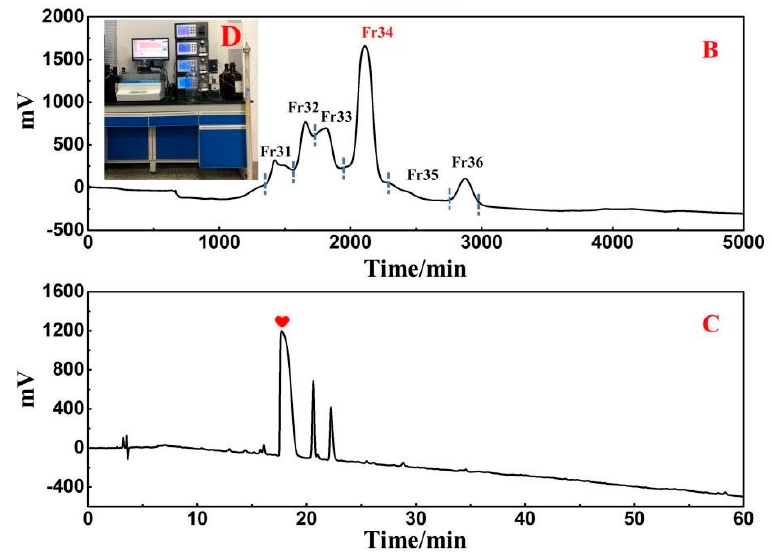
Figure 2. ( A ) The analytical chromatogram of fraction Fr3 on the ReproSil − Pur C18 AQ analytical column. ( B ) The fraction Fr3 chromatogram of medium-pressure liquid chromatography pretreatment with Sephadex LH-20 as the stationary phase. ( C ) The analytical chromatogram of fraction Fr34 on the ReproSil-Pur C18 AQ analytical column. ( D ) The actual Sephadex LH-20 medium-pressure liquid chromatography system.